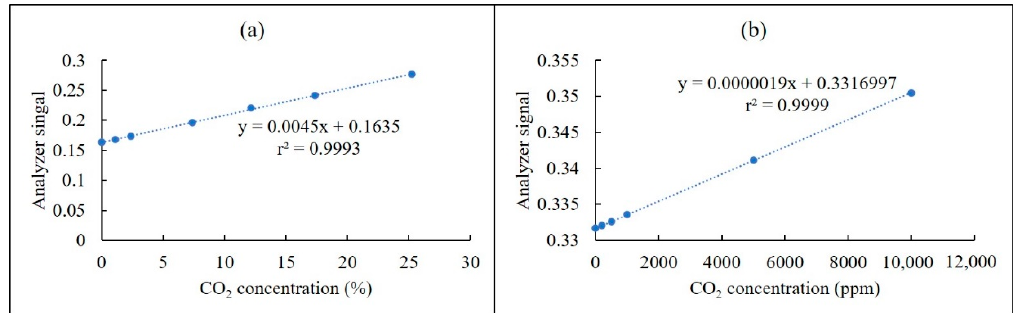
Figure 6. Calibration curves of the CO 2 NDIR analyzer at ( a ) the percentage channel (1.5 × 10 − 5 < SD < 13.3 × 10 − 5 ) and ( b ) the ppmv channel (1.5 × 10 − 5 < SD < 5.0 × 10 − 5 ).